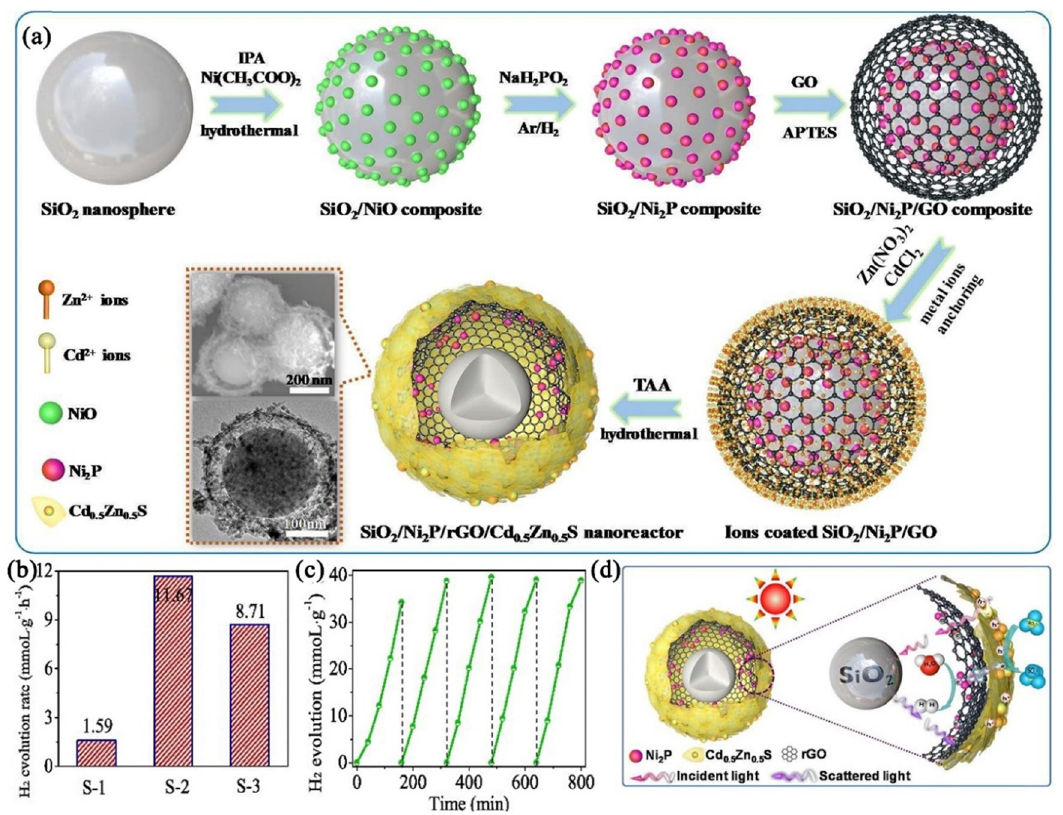
Figure 9: ( a ) Preparation process of SiO 2 /Ni 2 P/rGO/Cd 0.5 Zn 0.5 S nanocomposite, ( b ) H 2 yield of S - 1, S - 2, and S - 3 composites ( the composites are named S - 1, S - 2, and S - 3 composites with Ni 2 P loadings of 1 mmoL, 3 mmoL, and 5 mmoL, respectively ) , ( c ) S - 2 composite has 5 cycles of photocatalytic reaction under visible light, and ( d ) schematic diagram of the photocatalytic hydrogen evolution reaction of the composite [ 69 ] ; Copyright: 2021 with permission from Elsevier Science